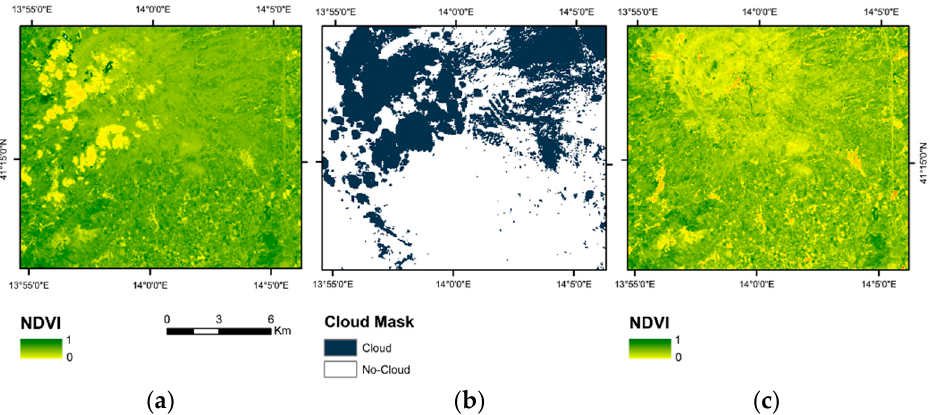
Figure 2. Example of derived product referred to the area of interest (tile T33TVF) from Landsat 8 acquired on the day-of-the-year 48 of year 2018: (a) raw Normalized Difference Vegetation Index (NDVI) data, (b) Cloud Mask, and c) filtered NDVI.